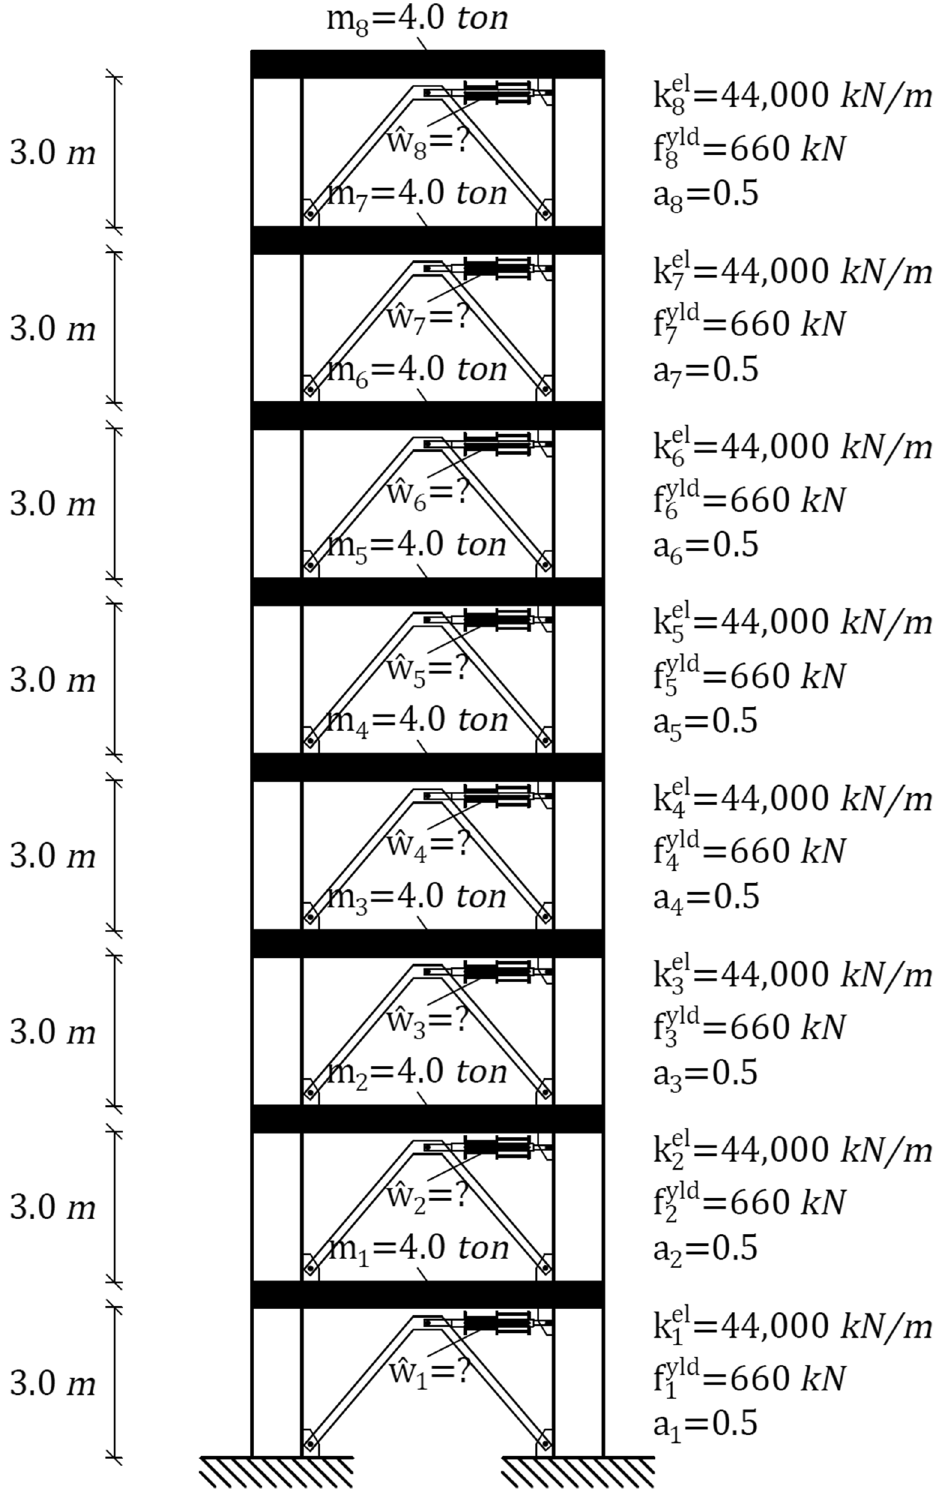
Figure 4. Eight-story inelastic shear-type